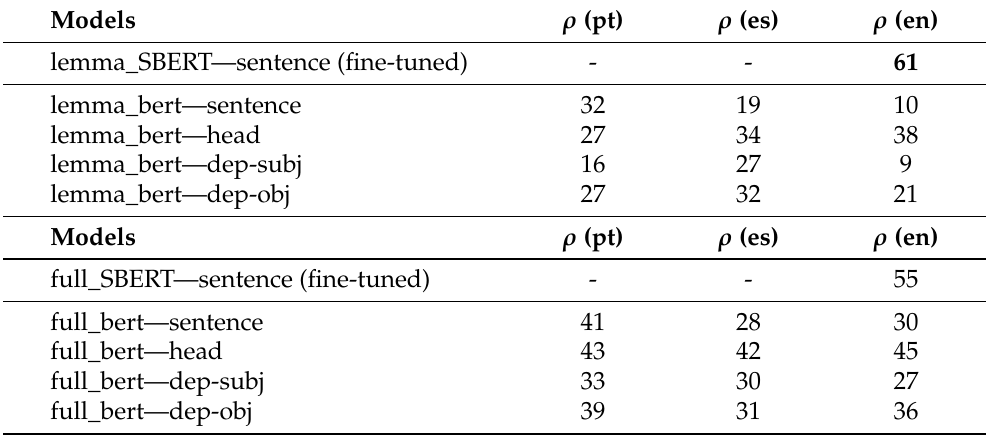
Table 2. Spearman correlation between different configurations of BERT and human judgments. Correlation was computed on benchmarks for English, Portuguese and Spanish. Top: scores obtained using lemma triples (original dataset). Bottom: scores with full sentences derived from the